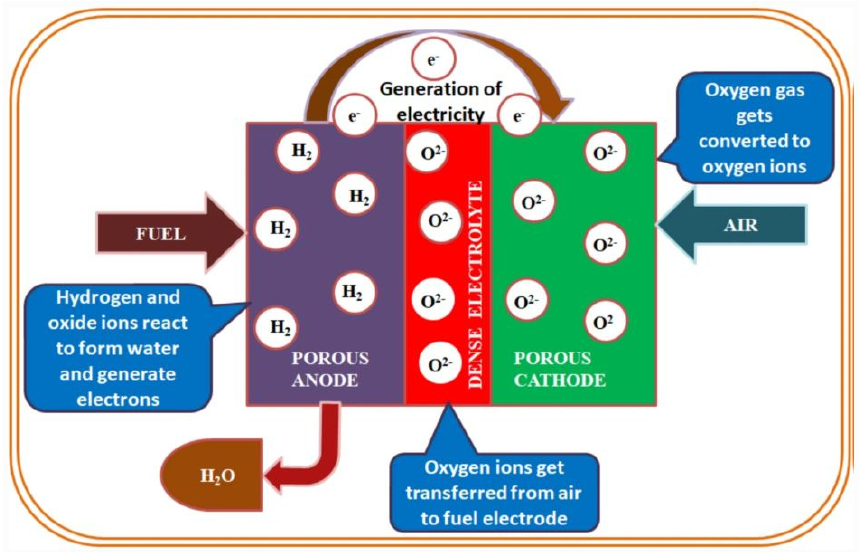
Figure 6. Schematic representation of solid oxide fuel cells [48]. Reproduced with permission from Hussain et al. (2020), © Springer, 2020 (Open access—Creative commons attribution 4.0).